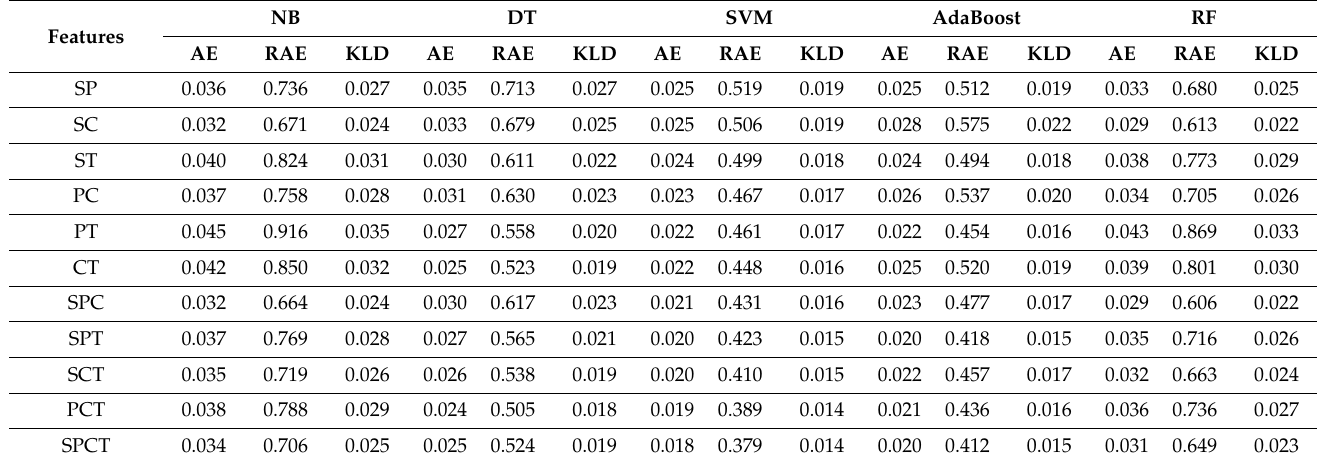
Table 6. Comparison of feature sets’ combinations using ML classifiers on SemEval2016.